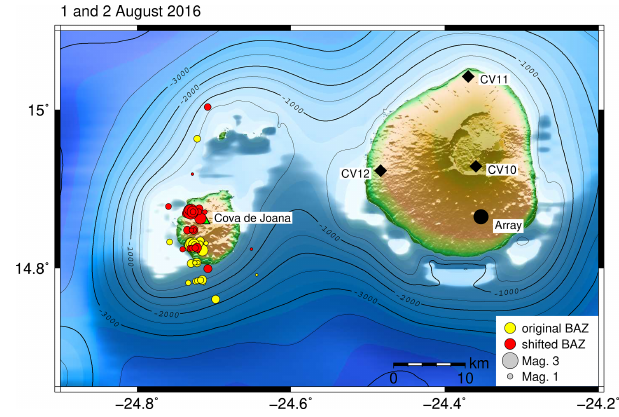
Figure 11. Earthquake locations during the seismic crisis of 1 and 2 August 2016. Yellow circles: original location of the earthquakes determined from the array data; red circles: corrected locations ac- cording to the mean systematic deviation of 6.5 ◦ in the backazimuth determination (see text for details). Topographic and bathymetry data are from Ryan et al.